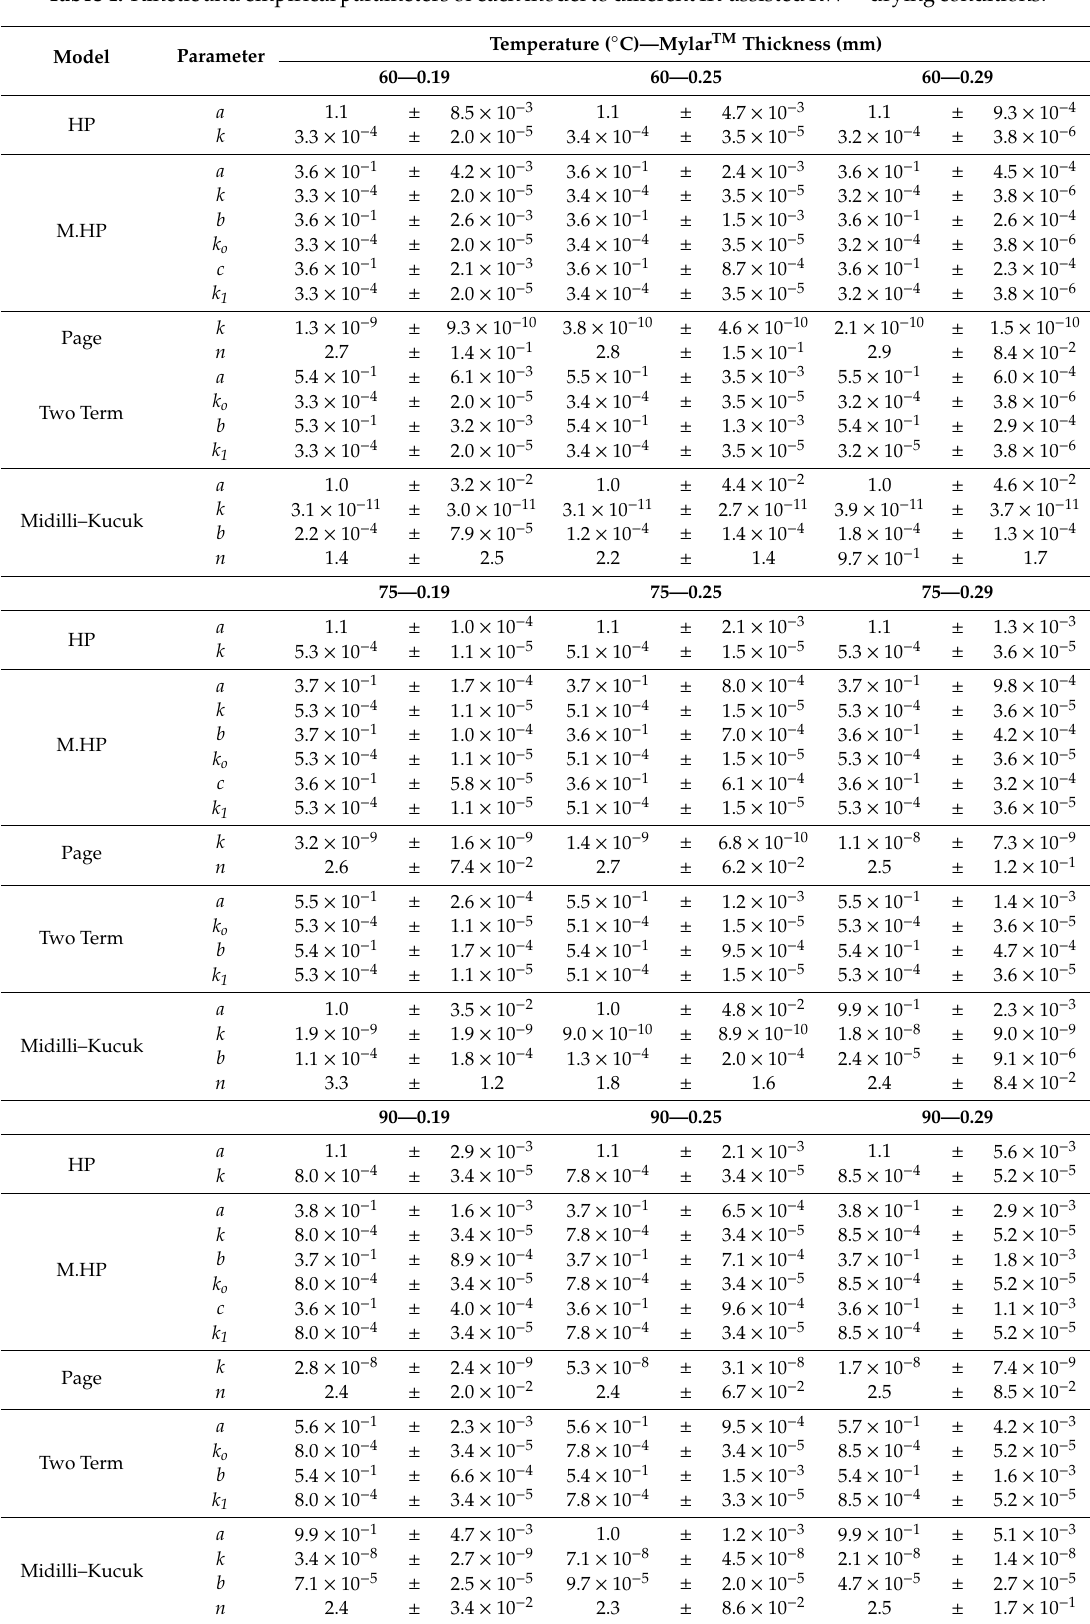
Table 4. Kinetic and empirical parameters of each model to di ff erent IR-assisted RW ™ drying conditions.